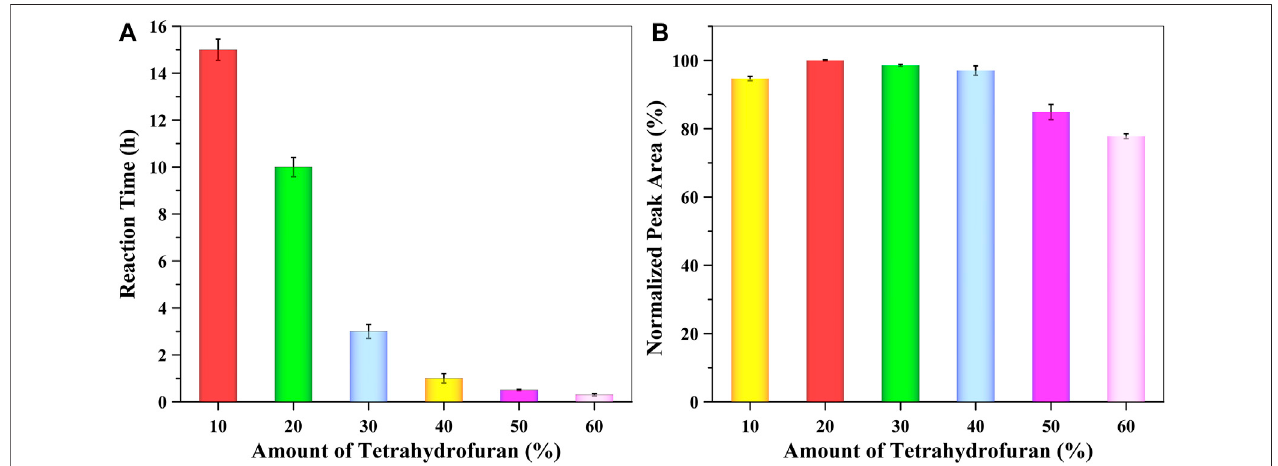
FIGURE 3 | Effect of the amount of THF on (A) reaction time and (B) extraction ef fi ciency ( n (cid:2) 3).